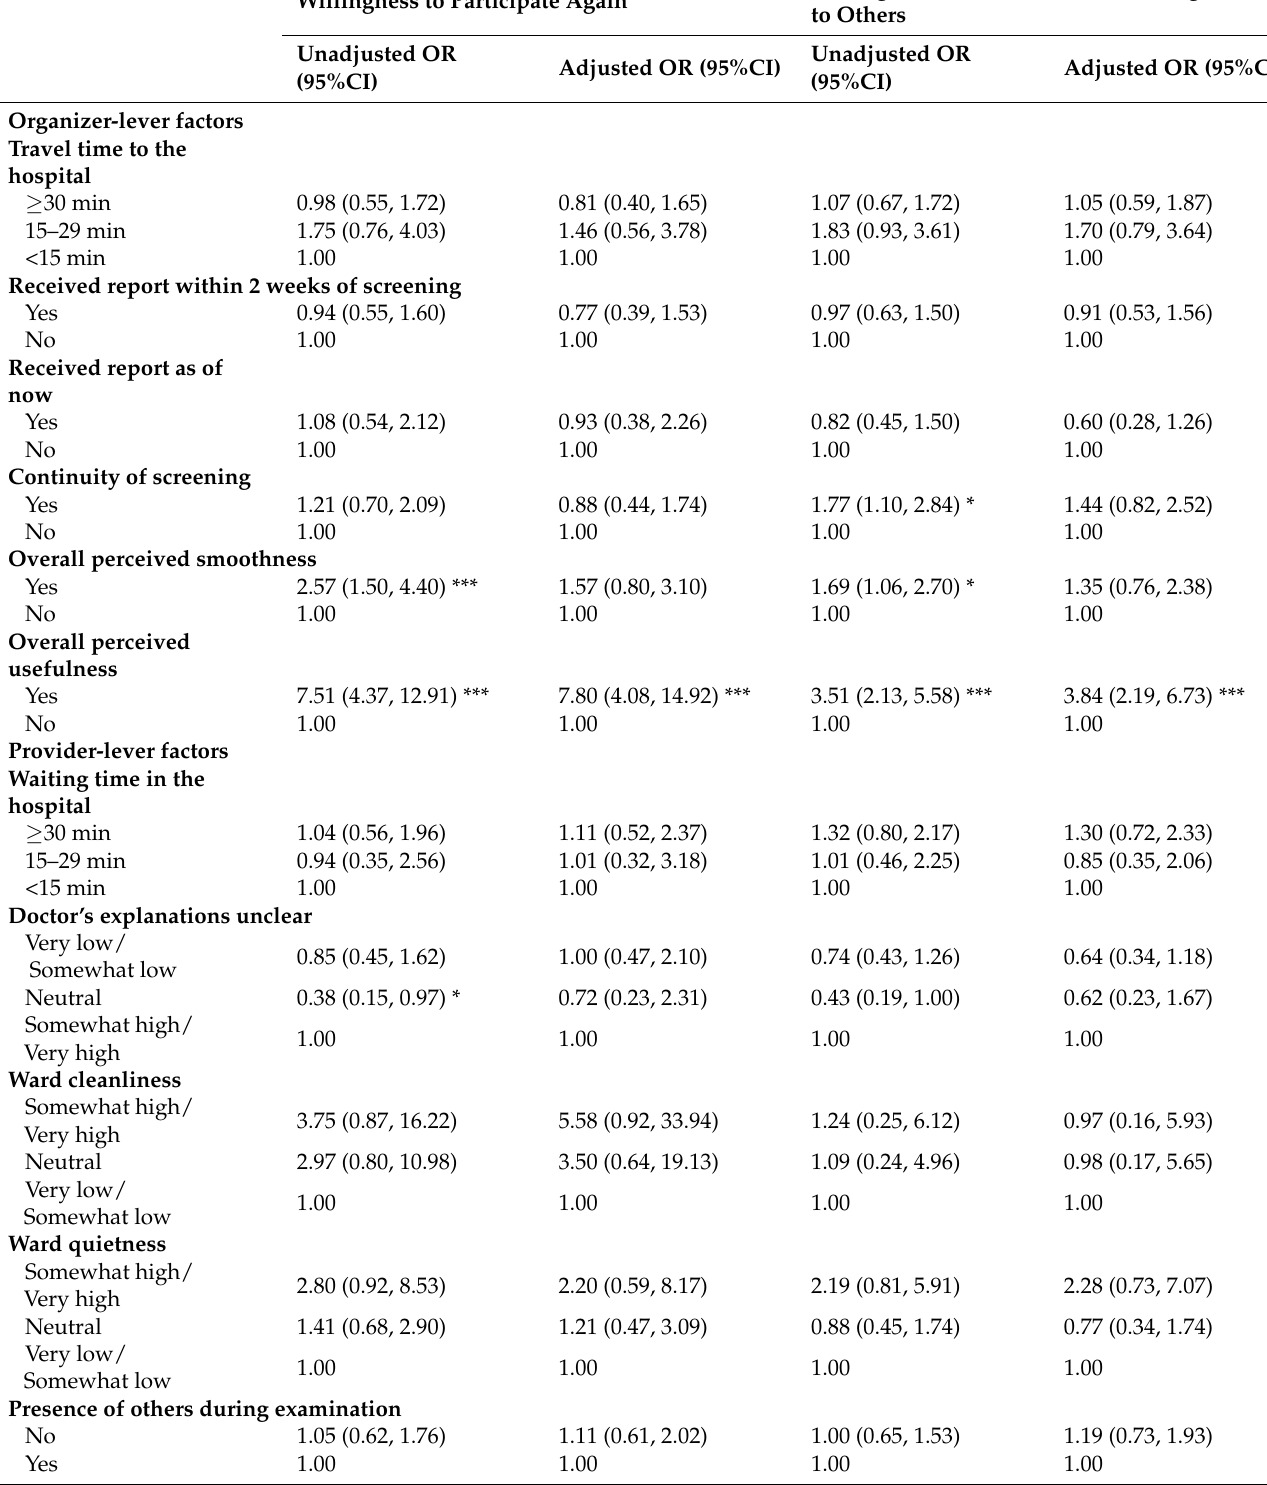
Table 4. Determinants of the willingness to participate again and to recommend screening to others of organized breast and cervical cancer screening in rural China 2018–2019. Willingness to Participate